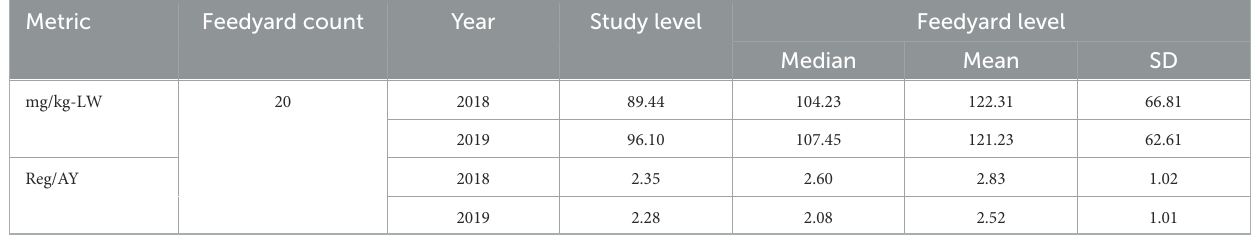
TABLE 12 Total mg/kg-LW and Reg/AY of not-medically important antimicrobials at the study and feedyard levels.